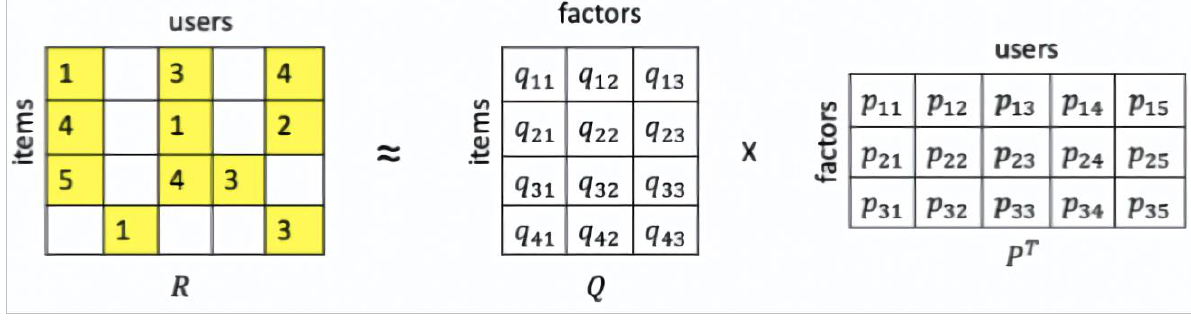
Figure 1. Matrix